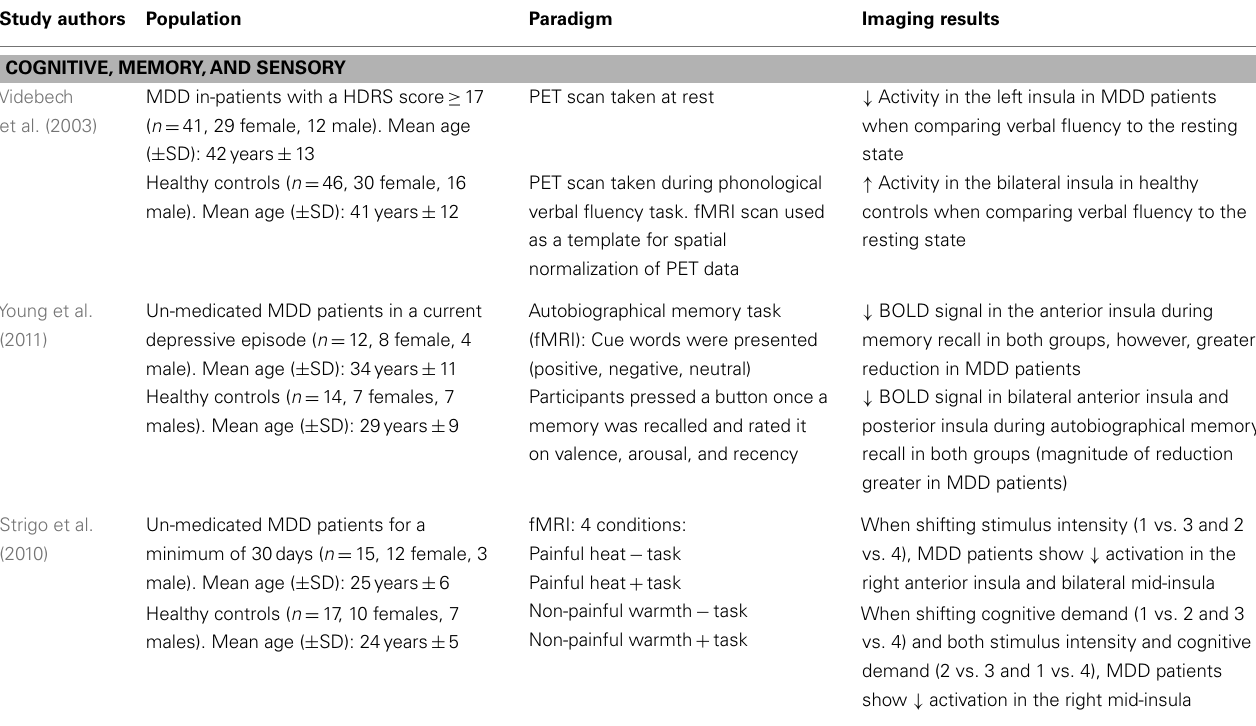
Table 4 | Imaging studies using task-related paradigms to examine functional and structural abnormalities in major depressive disorder (MDD). Study authors Population Paradigm Imaging